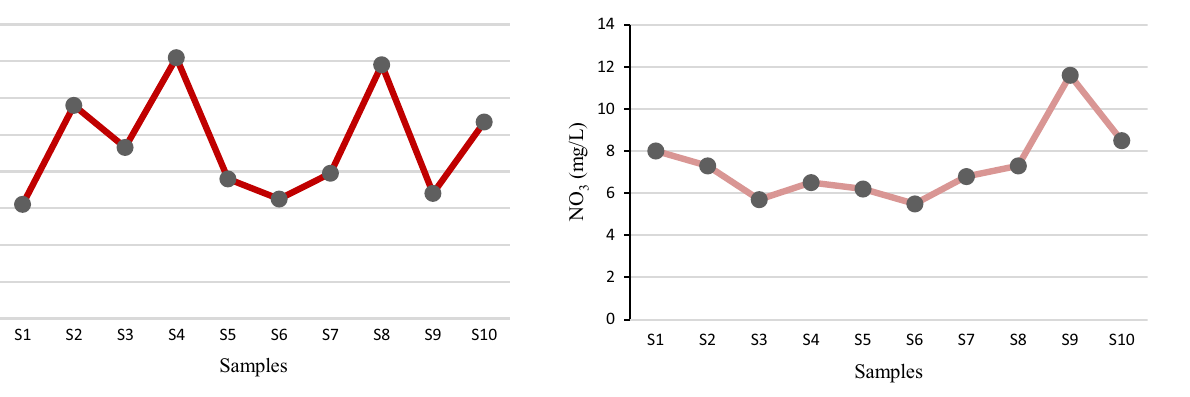
Fig. 6 Content of total suspended solids of analyzed dairy effluents